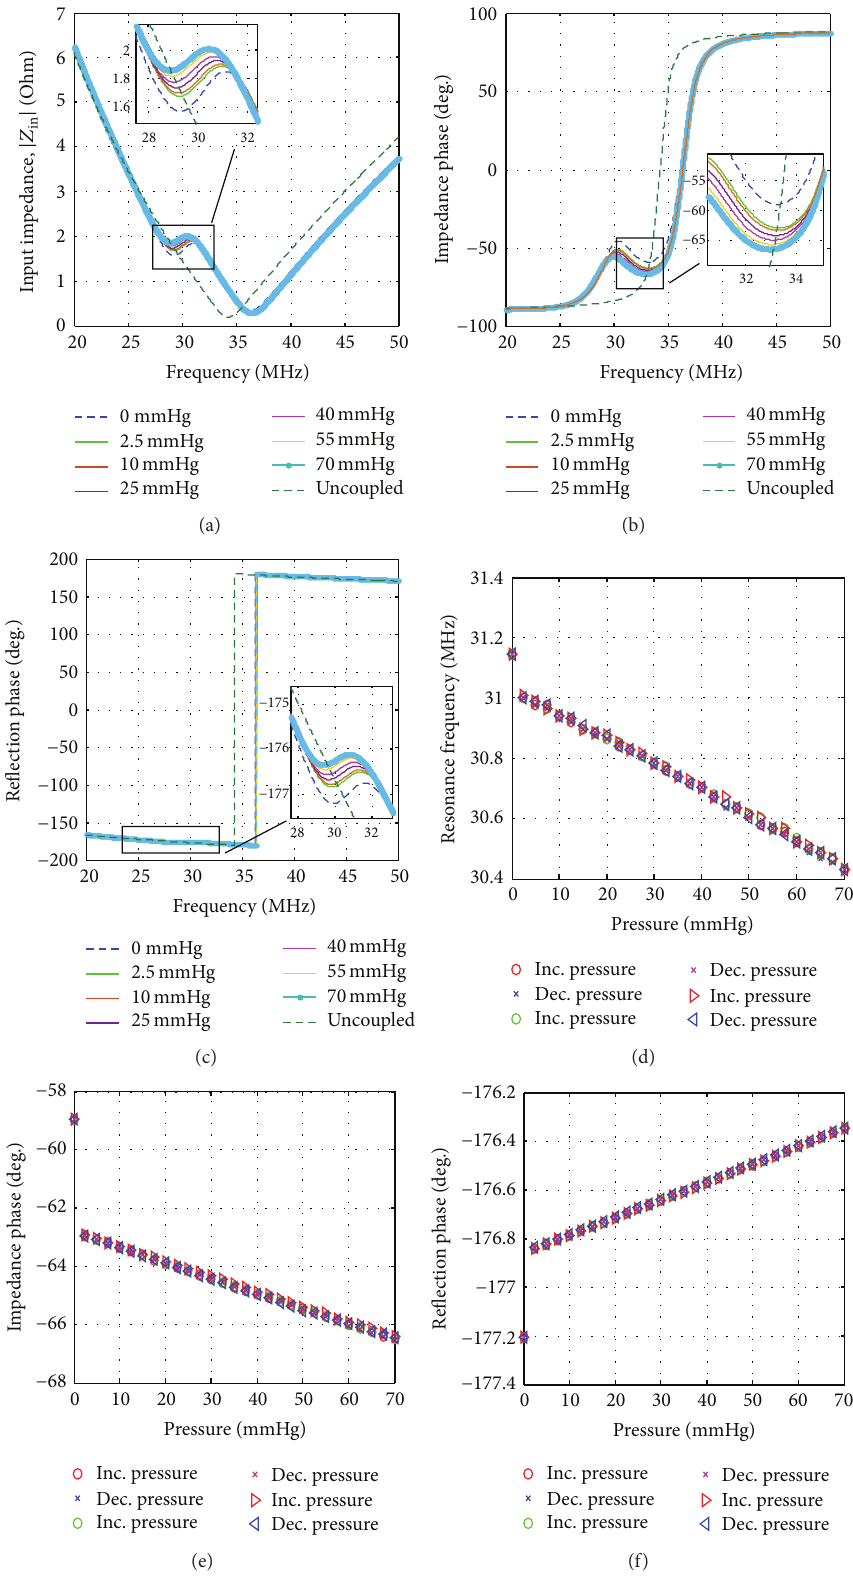
Figure 6: Measurement results obtained from sensor B. (a) Magnitude and (b) phase angle of the reader antenna’s input impedance. (c) Reflection phase of the sensor as a variable load. (d) Shift in the resonance frequency of the sensor as a function of pressure. (e) Phase dip variation. (f) Phase shift versus applied